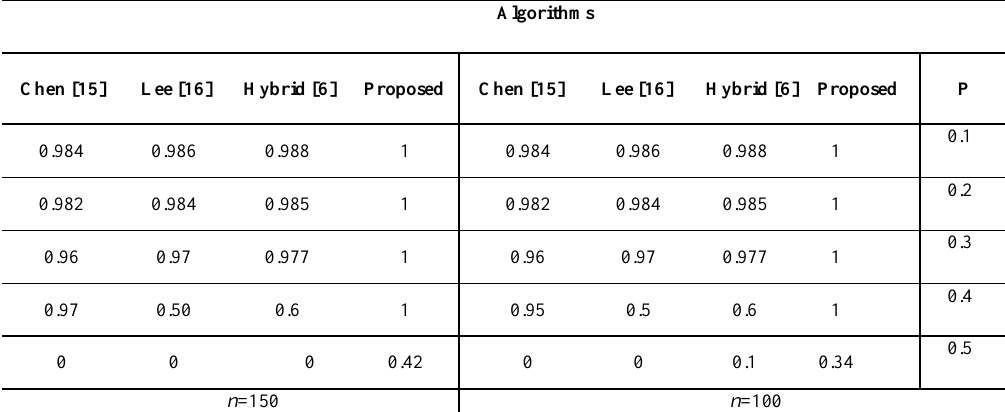
Table 2. Fault detection accuracy in the proposed method, Chen [15], Lee [16] and hybrid [6]